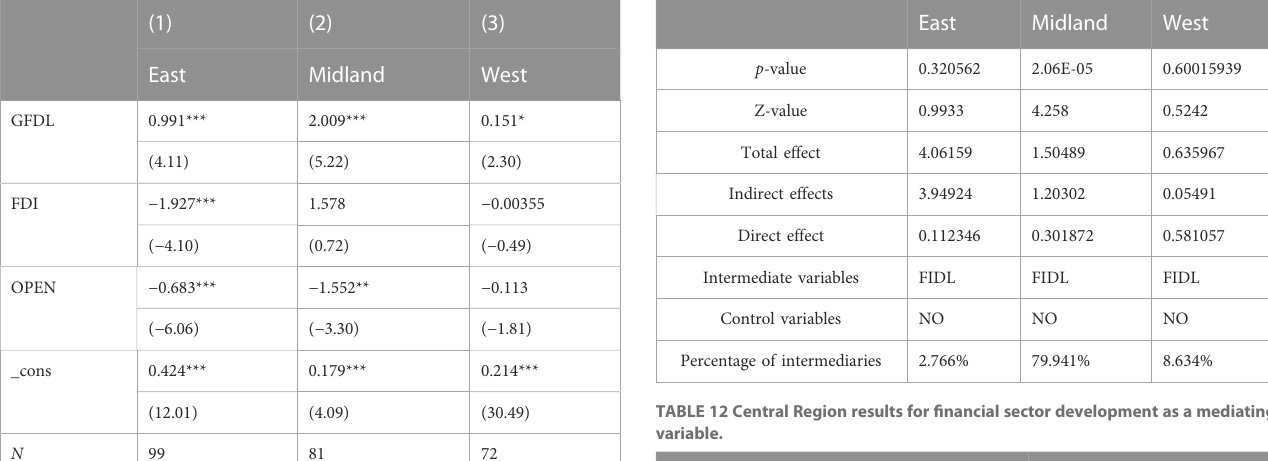
TABLE 9 Regression results based on the inclusion of control variables for Hypothesis 1 sub-region.